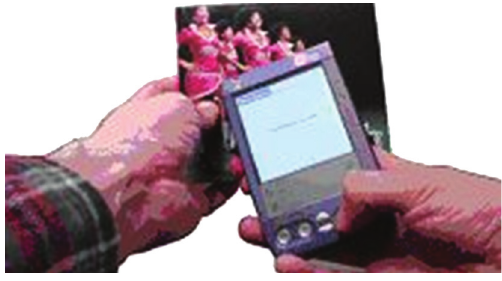
Figure 1: Using the QueryLens